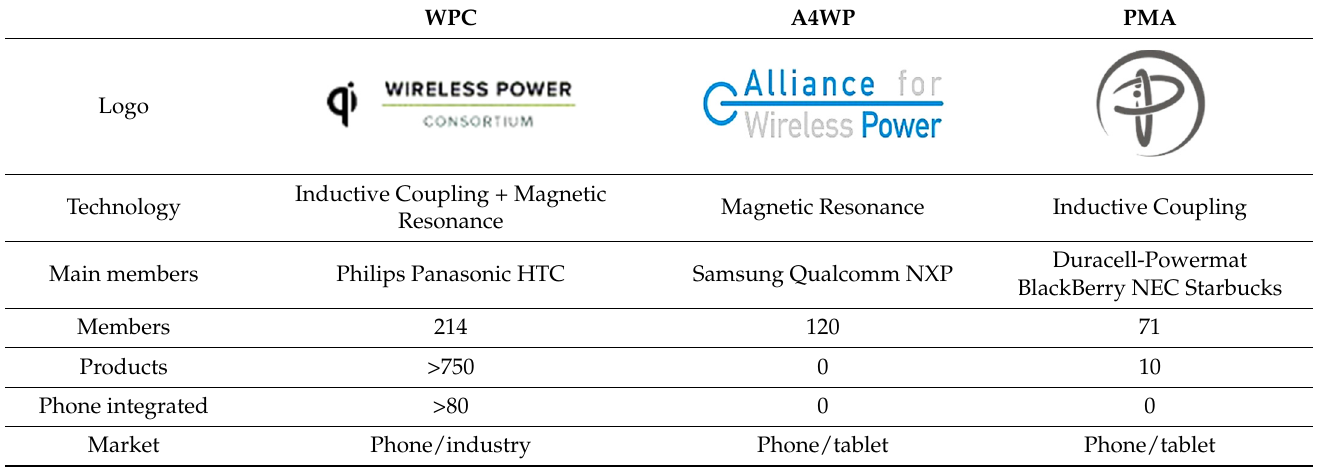
Table 1. Three major wireless charging technology standards.